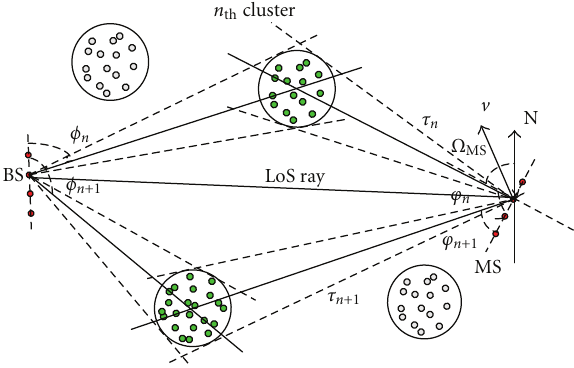
Figure 2: Single link in WINNER II channel